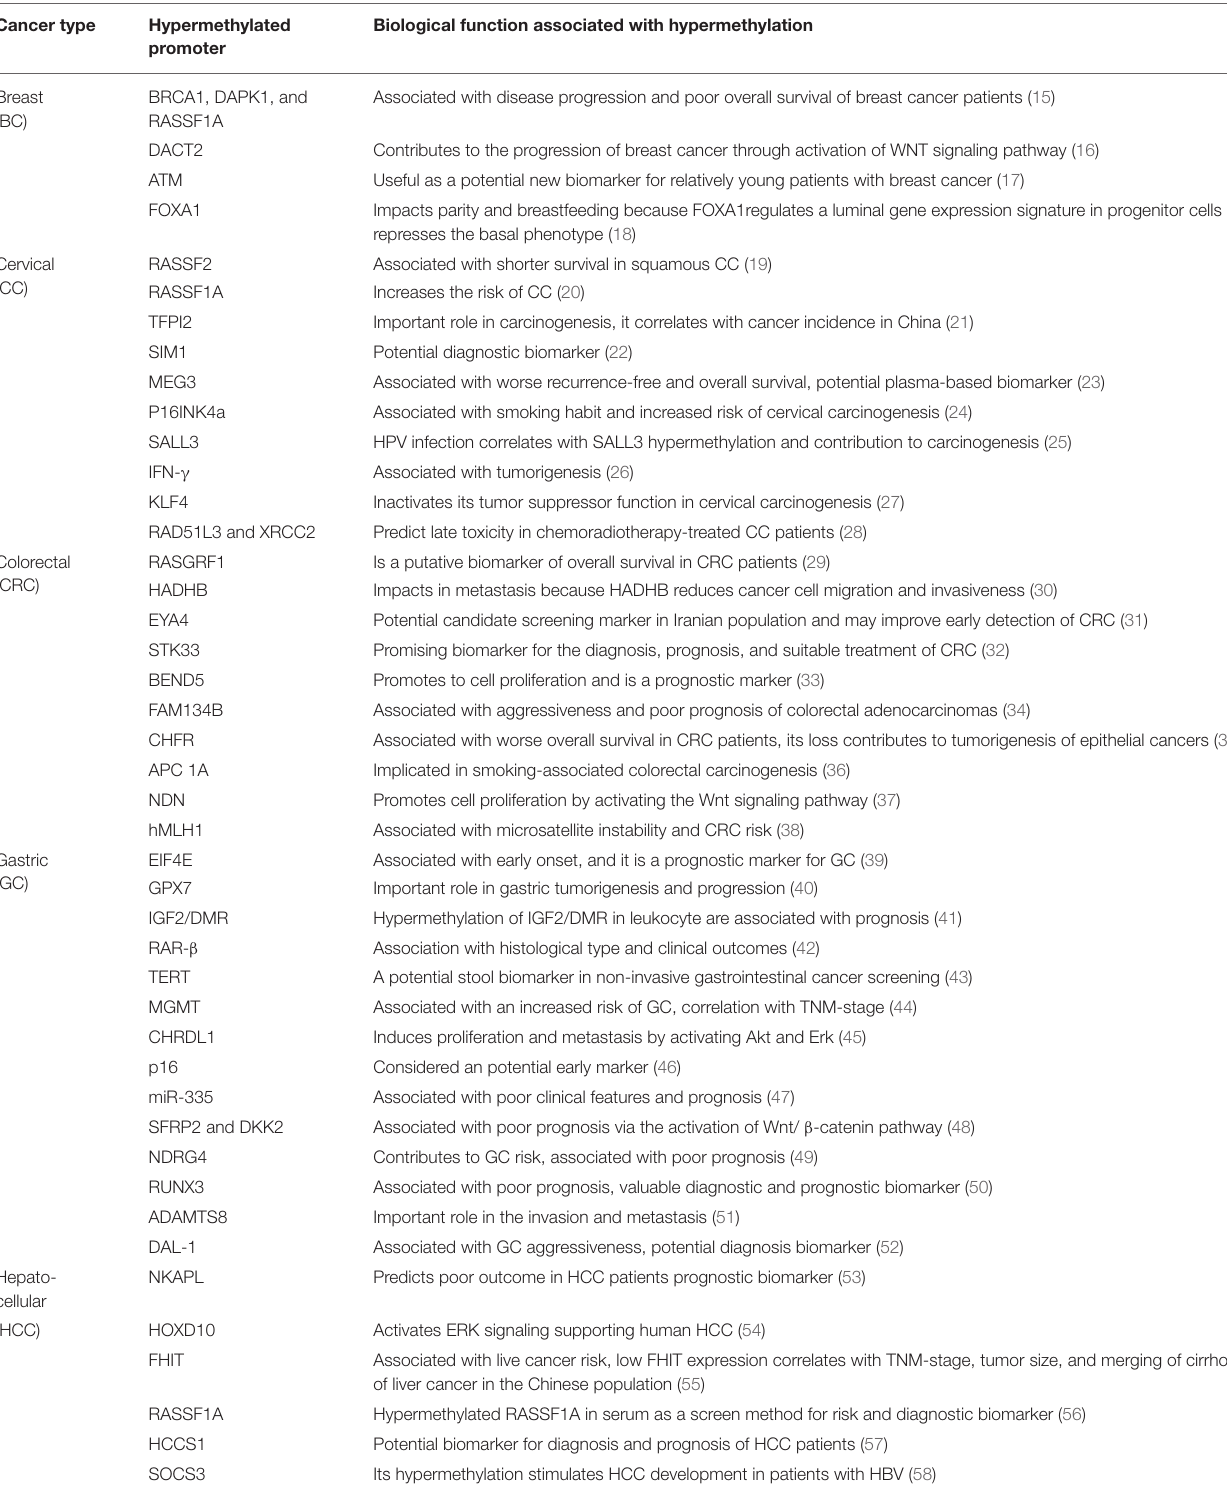
TABLE 1 | Hypermethylated promoters of genes associated with tumor suppression, prognosis, response to treatment, or as potential biomarkers. Cancer